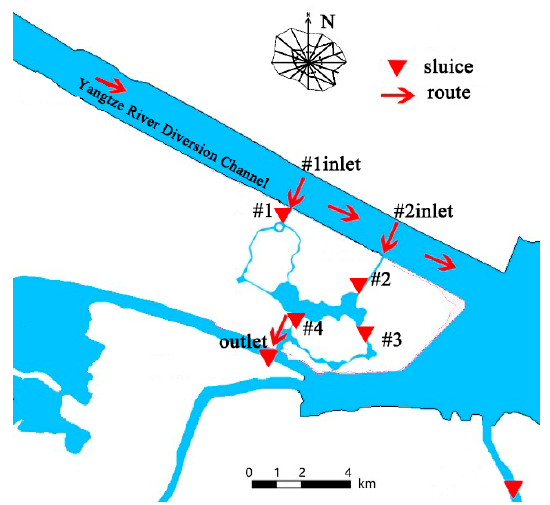
Figure 5. Route of water diversion through the sluice.